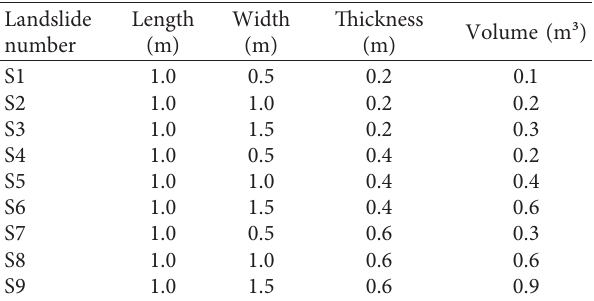
Table 2: Sizes and volume of landslides.